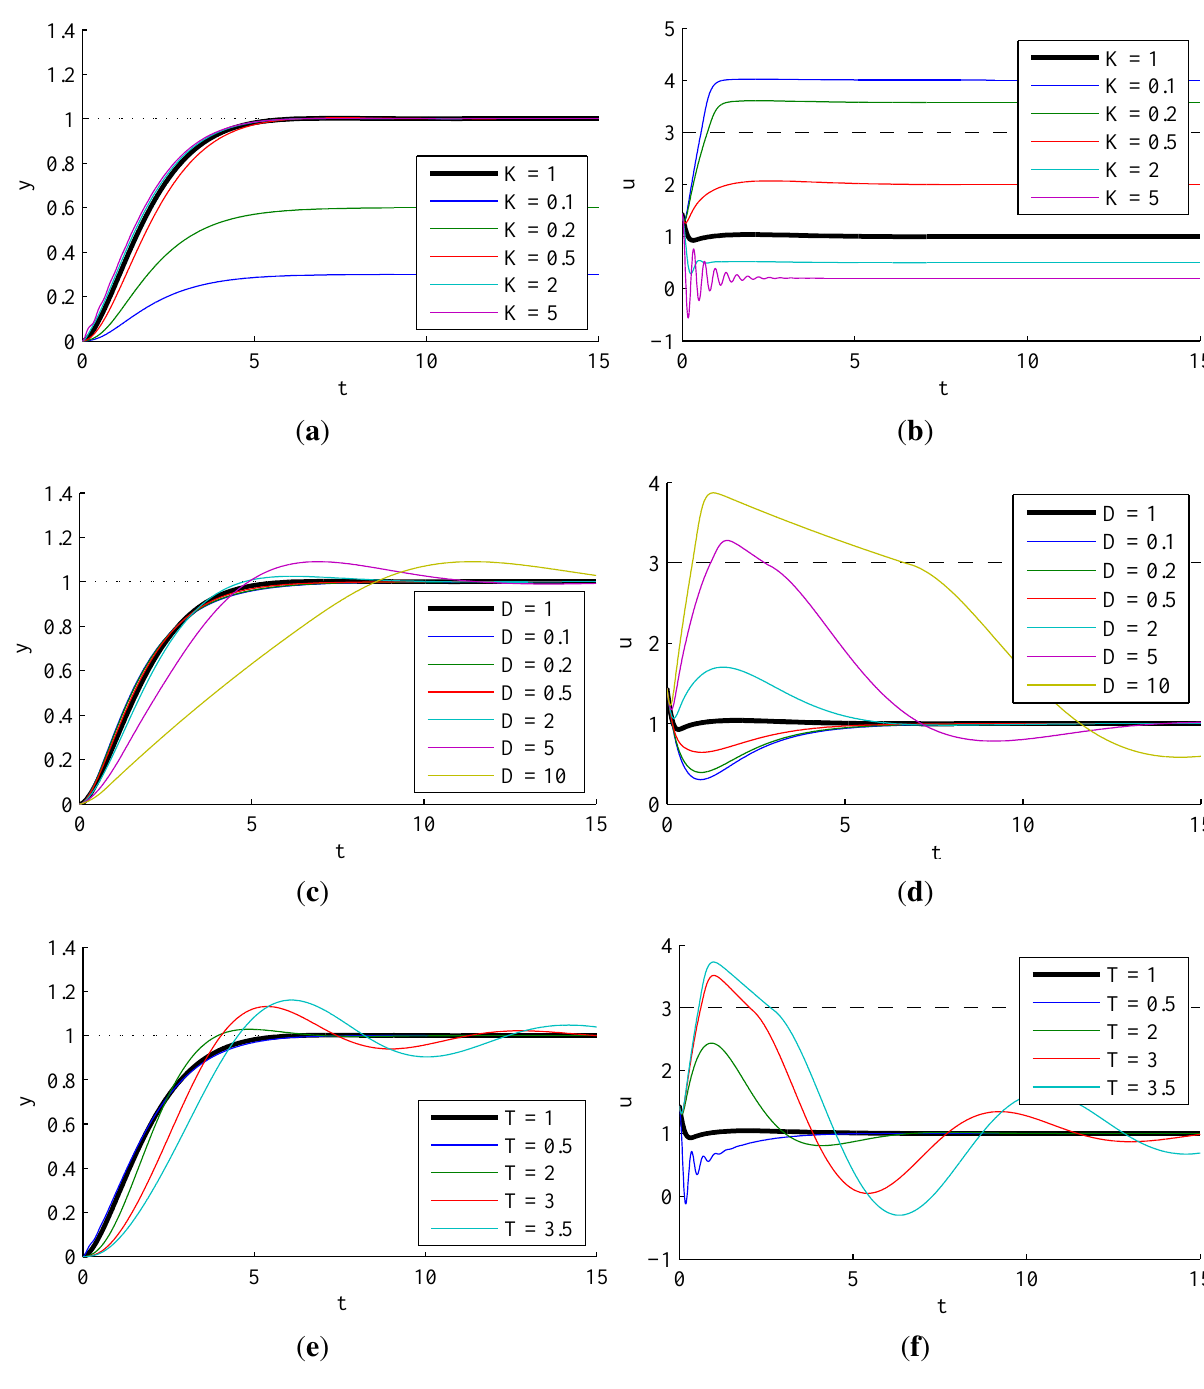
Figure 13. Experiment 3.2.3: effect of actuator saturation, ADRC controlling a second-order process with varying parameters. Nominal